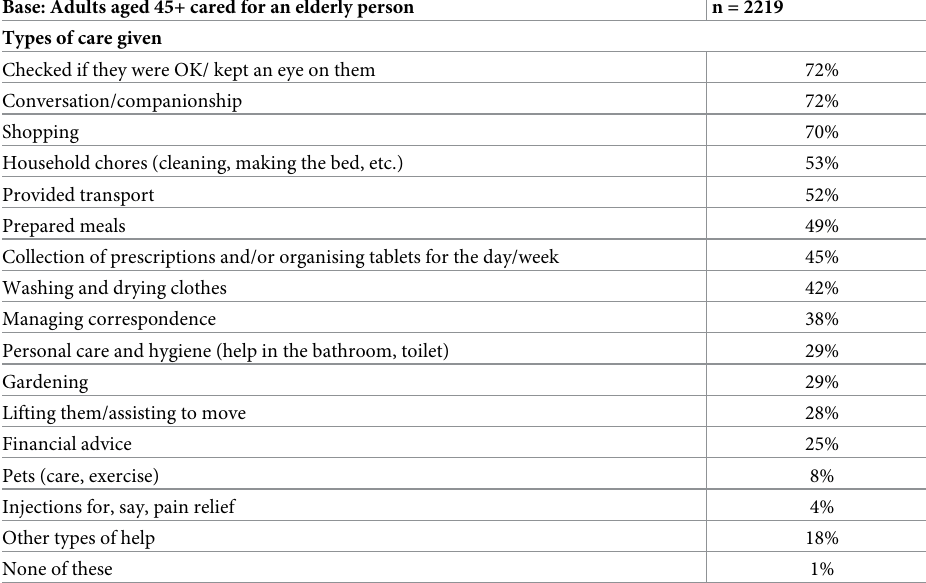
Table 2. Type of care given.